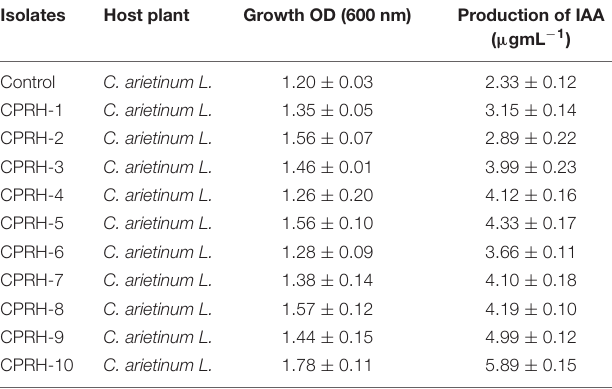
TABLE 2 | Indole acetic acid (IAA) production with different isolates obtained from the nodules of Cicer arietinum L . Isolates